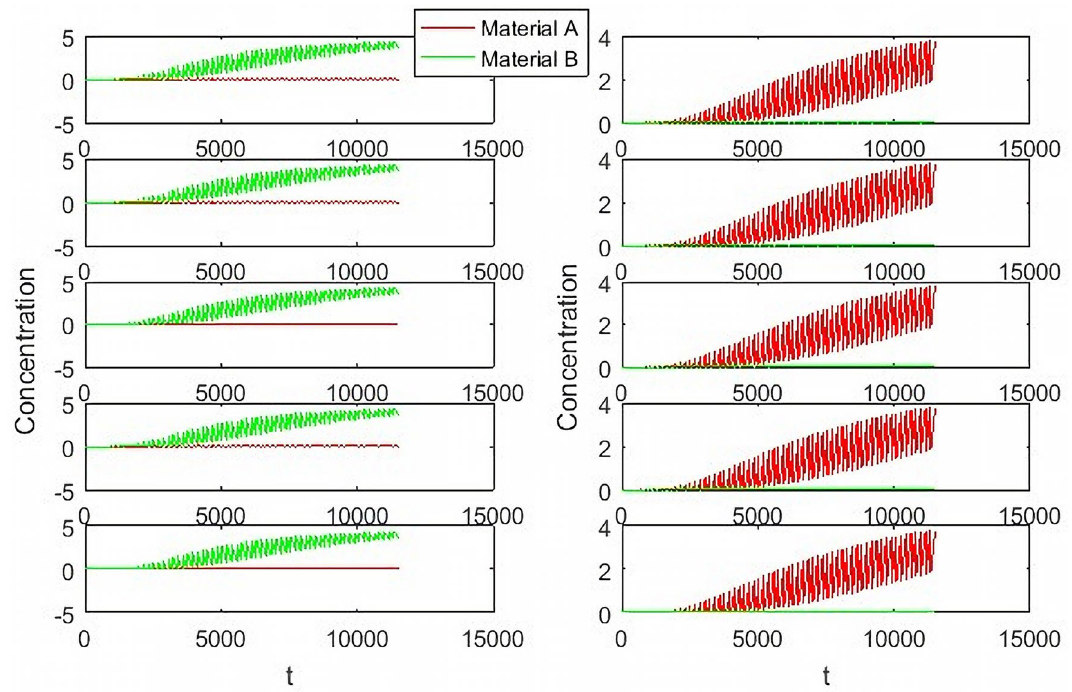
Figure 7. The influence of Zone 4 Flow rate for concentration.